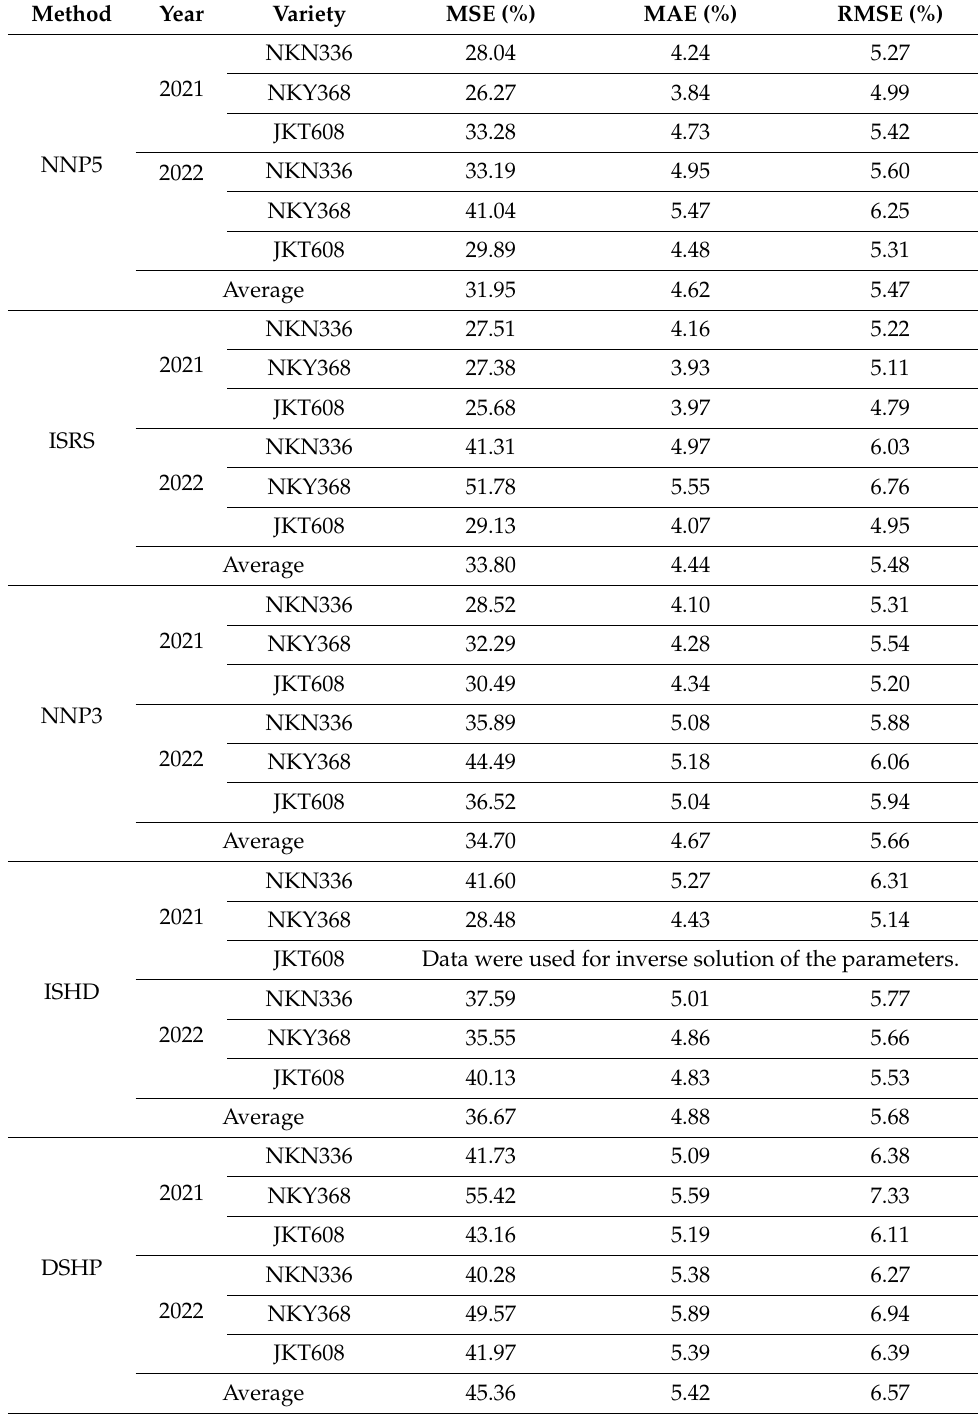
Table 9. Accuracy of soil moisture simulations in the root domain via different hydrodynamic parameter acquisition